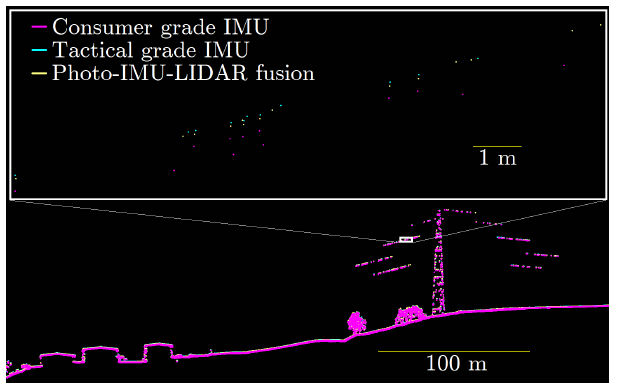
Figure 3. Point-Cloud section centered on a powerline. Ground truth point cloud (blue) has been computed using the Tactical Grade IMU trajectory. The point-cloud resulting from fusion of photogrammetry and LIDAR (yellow) uses consumer grade IMU and should be compared to the point-cloud using the same IMU without fusion